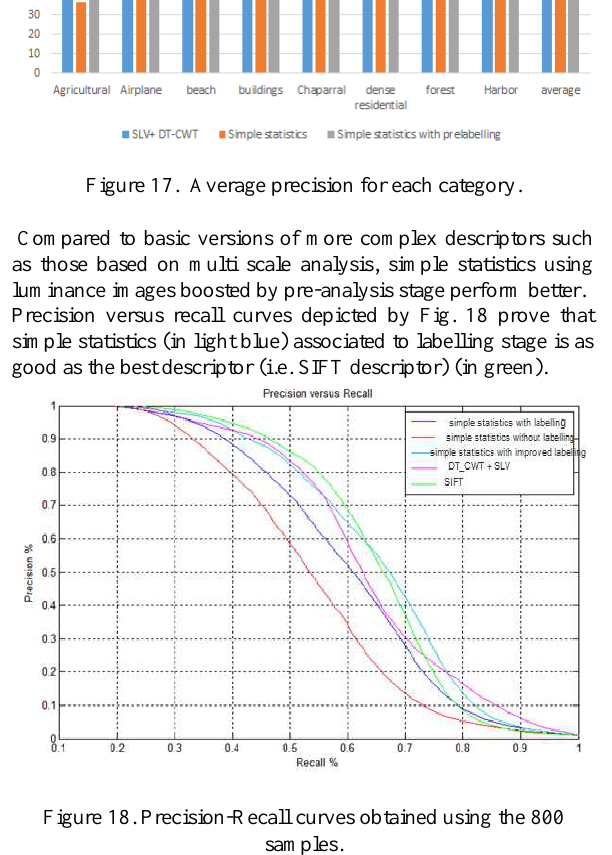
Figure 16. Retrieved image indexed by corresponding colour with improved labelling using simple statistics.